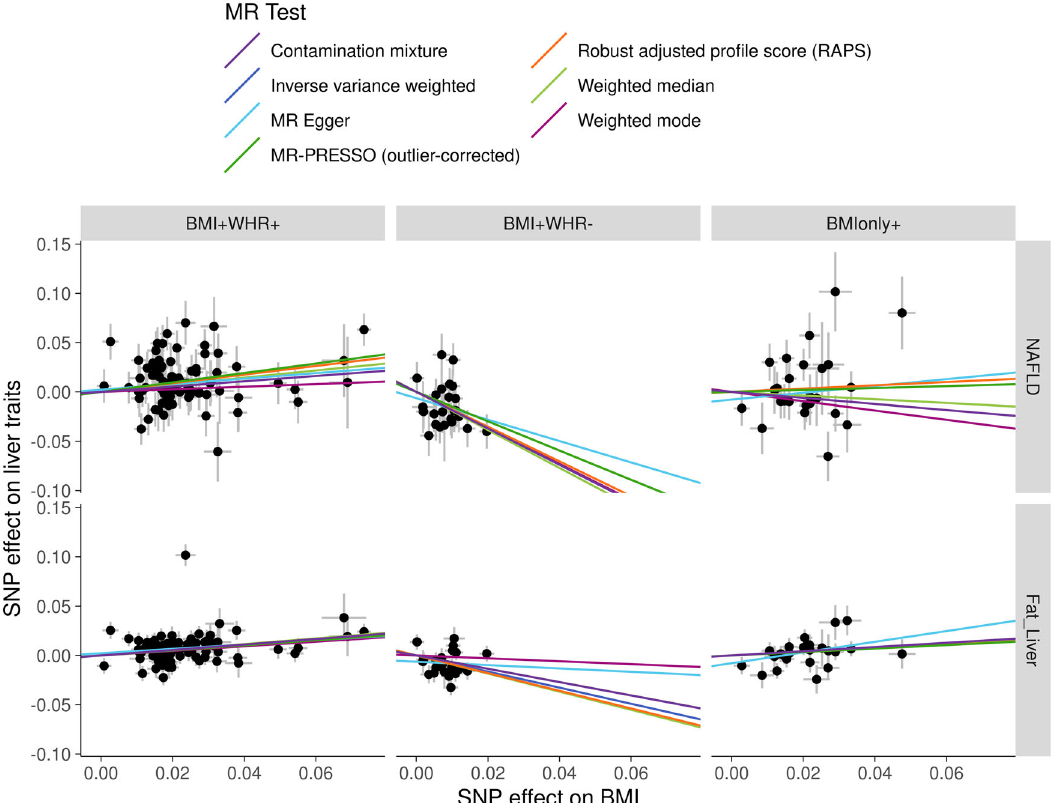
Fig. 3 Effect of body mass index (BMI) variants on non-alcoholic fatty liver disease (NAFLD) and liver fat accumulation using group-speci fi c Mendelian randomization. A total of 159 genetic instruments categorized based on their association with BMI and waist-to-hip ratio (WHR): Left panel BMI + WHR + (nominal signi fi cant effects on BMI and WHR with consistent directions), center panel BMI + WHR − (nominal signi fi cant effects on BMI and WHR with opposite directions) and right panel BMIonly + (nominal signi fi cant effects on BMI